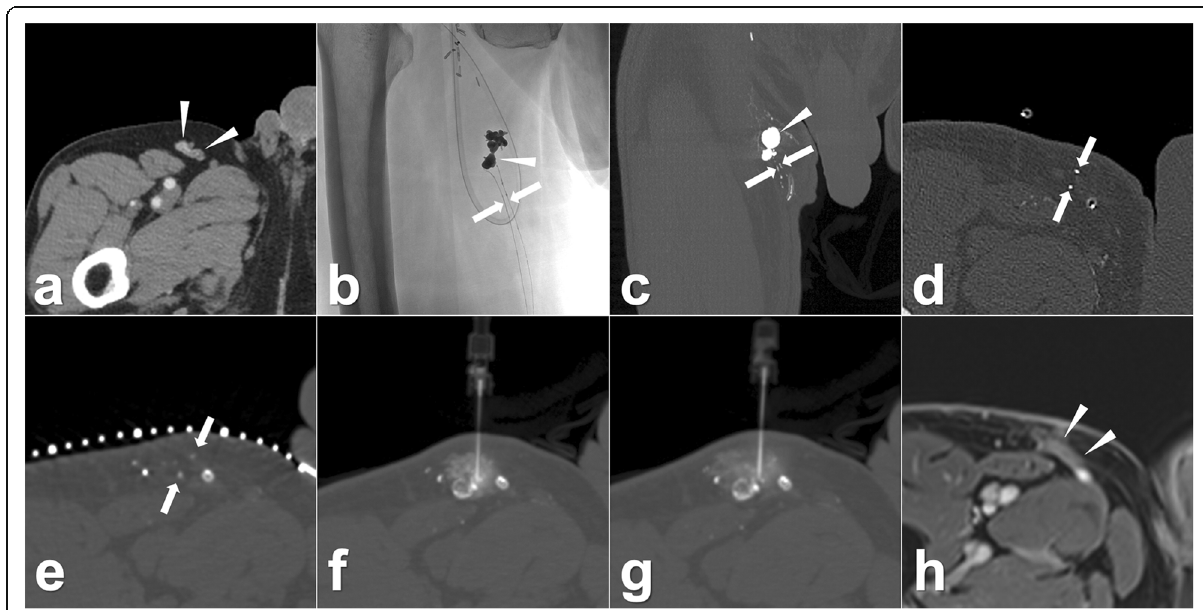
Fig. 5 Images from a patient who underwent a melanoma resection 1 year before. a Contrast-enhanced CT showed a suspicious metastatic lymph node (white arrowheads) at the right proximal thigh. Hence, a right inguinal lymphadenectomy was performed, and the postoperative pathological result confirmed the metastasis of the lymph node. Because of the postoperative LL, the therapeutic TL was performed showing definite iodinated oil extravasation (white arrowhead) from two lymphatic vessels (white arrows) using both fluoroscopy ( b ) and a CT scan, obtaining coronal ( c ) and axial ( d ) reconstructions. Twenty-eight days after TL, percutaneous ALVS was performed owing to the continuous leakage. e The two target afferent lymphatic vessels (white arrows) close to the leakage could still be identified. f During the puncture, the needle tip was located between the two afferent lymphatic vessels, and 1 mL of contrast fluid was injected that showed an ideal distribution covering both the target lymphatic vessels. g After injection of 2.0 mL of 95% ethanol, a CT scan was performed which showed a nebulous dispersal of the contrast completely covering the two target lymphatic vessels. One day later, the leakage ceased and the drainage could be removed. The patient was discharged on the same day. h Around 3 months later, magnetic resonance imaging showed no tumour recurrence and fluid accumulation. A mild enhancement (white arrowheads) at the region of sclerotherapy could be observed which indicated clinically inapparent scarring after ALVS. In the further follow-up for 1 year, no relapse of the tumour or lymphatic leakage was found. ALVS Afferent lymphatic vessel sclerotherapy, CT Computed tomography, LL Lymphatic leakage, TL Transpedal